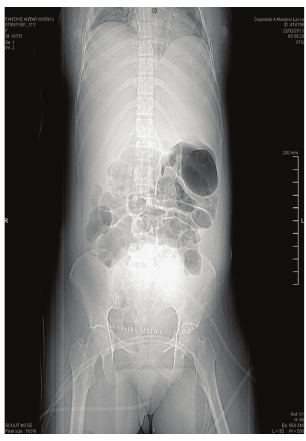
Figure 1: CT scan: intraparenchymal hepatic hematoma with active bleeding from the right and left ramus of hepatic artery. A concomitant subcapsular hematoma with an extra capsular caudal extension in the paracolic gutter.